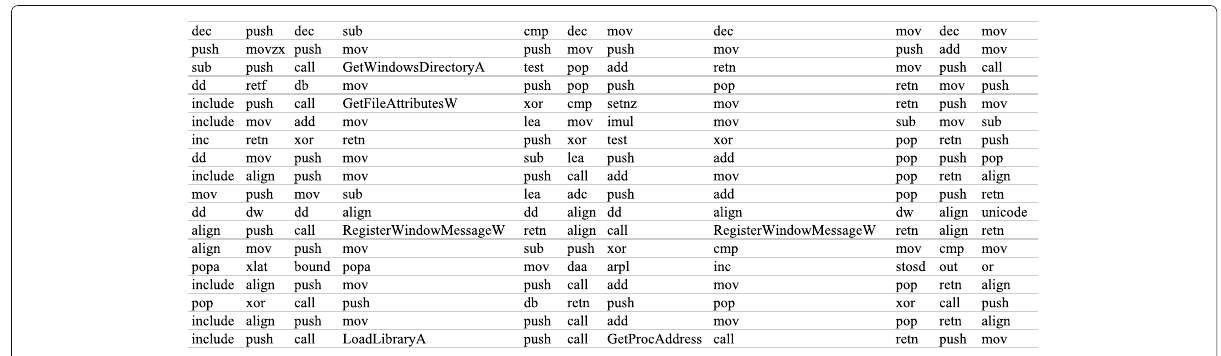
Fig. 6 A part of malware opcode and API call name sequence samples